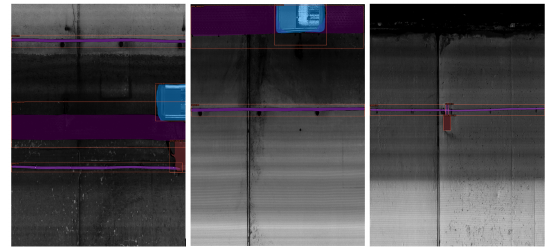
Figure 6. Instance segmentation result without any postprocessing